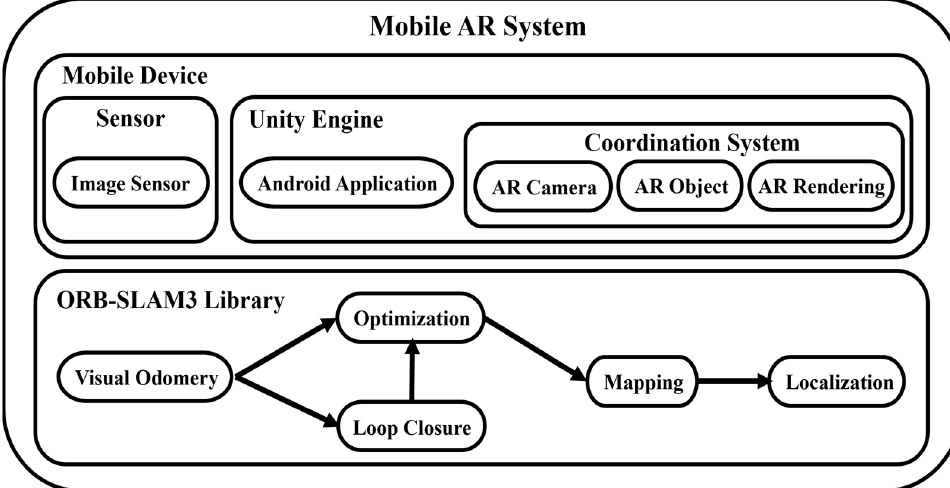
Figure 4. Proposed Mobile AR System Structure.